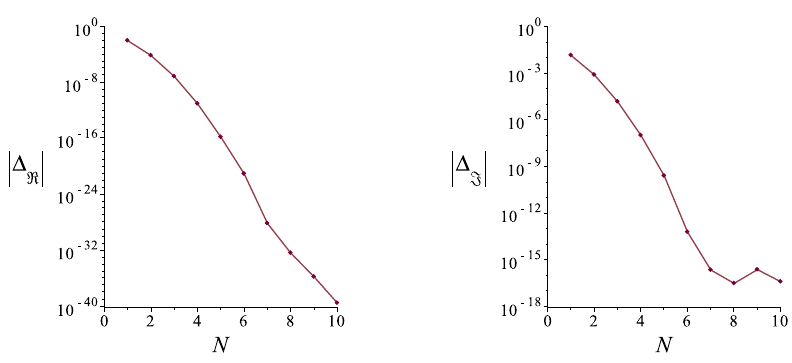
Figure 6 . Relative deviations of the lateral Borel resummation S + ( top ) from the nonperturbative q 2 (cid:25) result N + i at g s = 1. The real part (left) and the imaginary part (right) are plotted 2 g s N +1